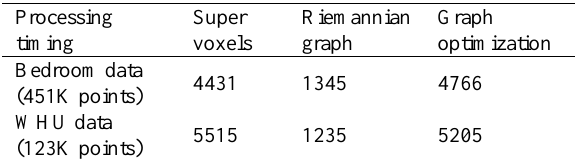
Table 1. Execution time of test (in milliseconds).